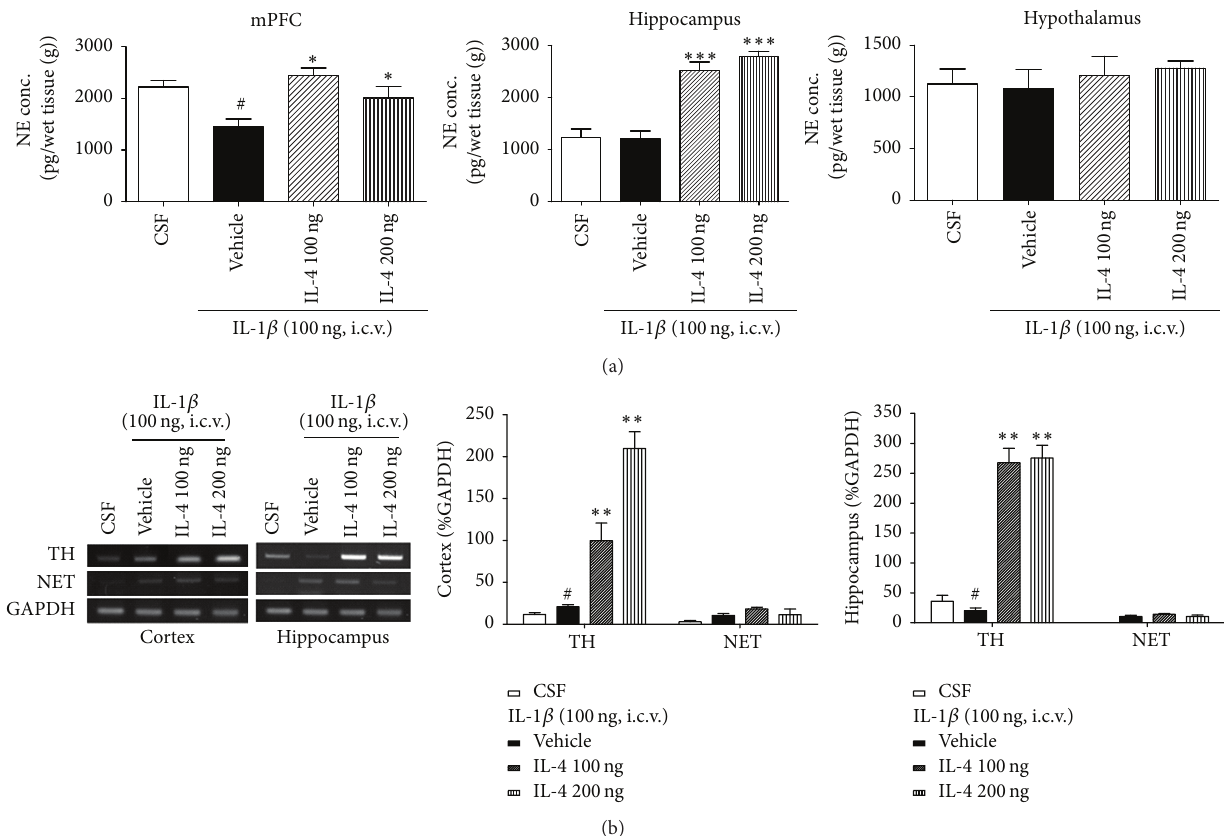
Figure 4: (a) Effect of IL-4 injection 2 hours after injection of i.c.v. IL-1 𝛽 on NE concentration. Mean ( ± SEM) concentrations (picogram per gram) of NE within the mPFC, hippocampus, and hypothalamus among rats. Each value represents the mean ± SEM. # 𝑃 < 0.05 compared to the CSF and ∗ 𝑃 < 0.05 , ∗∗∗ 𝑃 < 0.001 compared to the IL-1 𝛽 treated group. Control, 𝑛 = 5 ; IL-1 𝛽 , 𝑛 = 5 ; IL-4 100 ng, 𝑛 = 5 ; IL-4 200 ng, 𝑛 = 5 . (b) Effect of IL-4 injection 2 hours after injection of i.c.v. IL-1 𝛽 on NET and TH mRNA levels in the brain. Values are means ± SEM. Relative % GAPDH of NET and TH mRNA levels within the mPFC and hippocampus among rats. Each value represents the mean ± SEM. # 𝑃 < 0.05 compared to the CSF and ∗∗ 𝑃 < 0.01 , compared to the IL-1 𝛽 treated group. Control, 𝑛 = 5 ; IL-1 𝛽 , 𝑛 = 5 ; IL-4 100ng, 𝑛 = 5 ; IL-4 200 ng, 𝑛 = 5